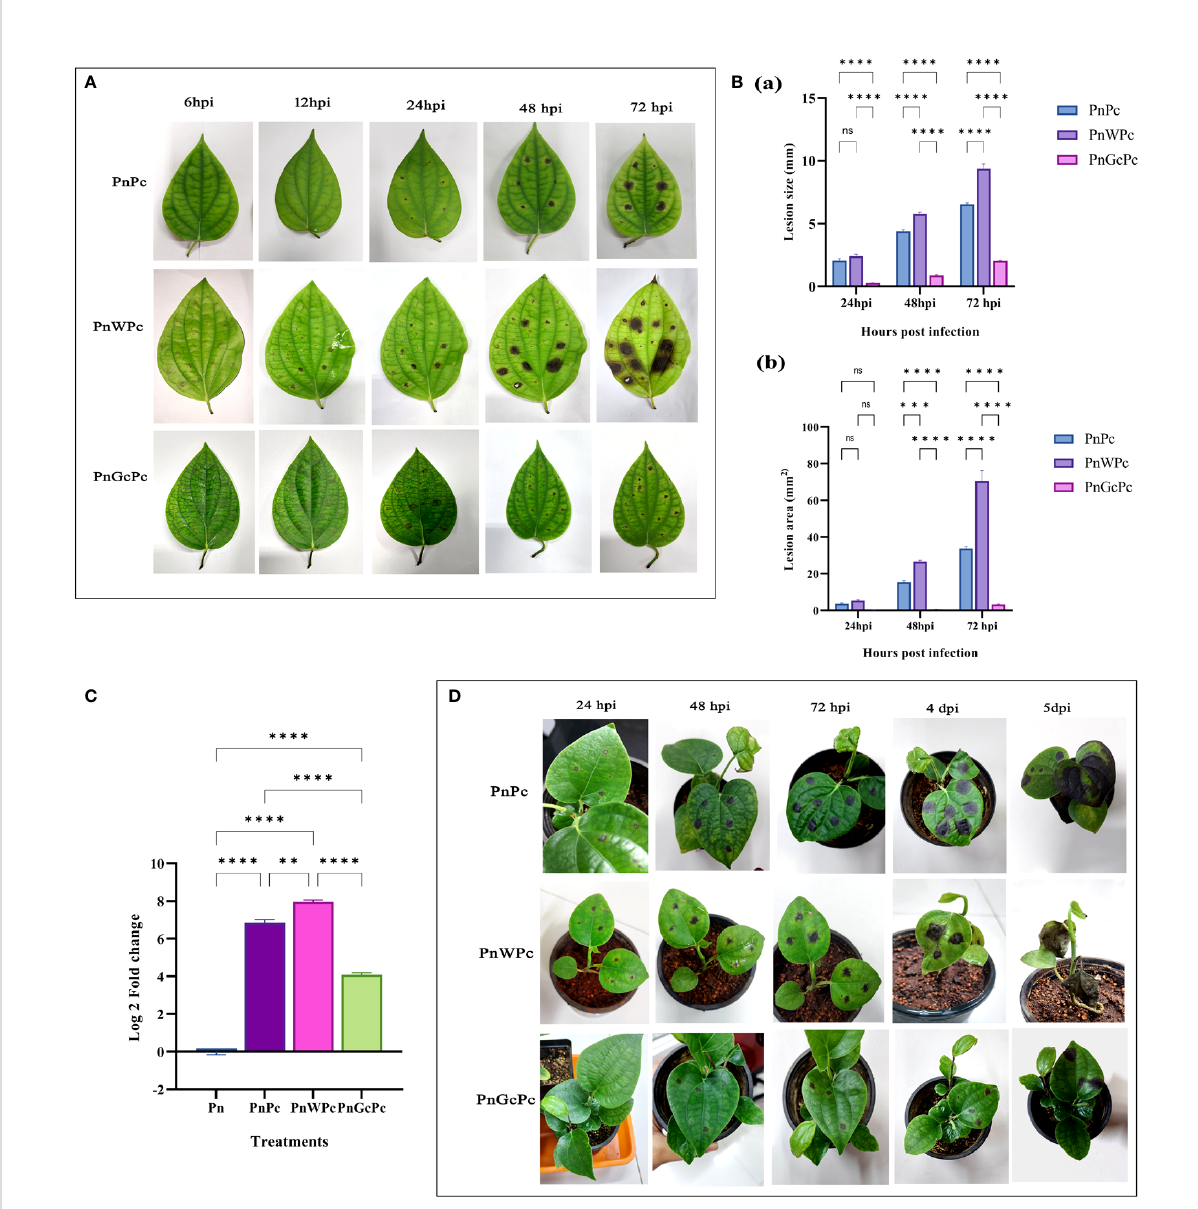
FIGURE 2 P. capsici infection progression in P. nigrum after speci fi c treatments (A) P. nigrum detached leaves (PnPc: P. nigrum infected with P. capsici , PnWPc: P. nigrum infected with P. capsici 24h post in fi ltration with water & PnGcPc: P. nigrum infected with P. capsici 24h post in fi ltration with GC) at 6, 12, 24, 48 & 72 hpi (B) Comparison of P. capsici infection lesion size (a) Lesion diameter (mm) (b) Lesion area (mm 2 ), among treatments at 24, 48 & 72 hpi (C) Quanti fi cation of the relative growth & absolute biomass of P. capsici in detached P. nigrum leaves using qRT- PCR with P. capsici speci fi c 28S rRNA primers. (Pn: P. nigrum control, PnPc: P. nigrum infected with P. capsici , 24 hpi, PnWPc: P. nigrum infected with P. capsici 24h post in fi ltration with water, 24 hpi, PnGcPc: P. nigrum infected with P. capsici 24h post in fi ltration with GC, 24 hpi), (D) P. capsici infection progression in control (Pn), water in fi ltrated (PnW), and GC in fi ltrated P. nigrum (PnGc) seedlings at 24hpi, 48hpi, 72hpi, 4dpi & 5dpi. Comparative gene expression was calculated according to the 2 − DD C T method (Schmittgen and Livak, 2008). One-way ANOVA